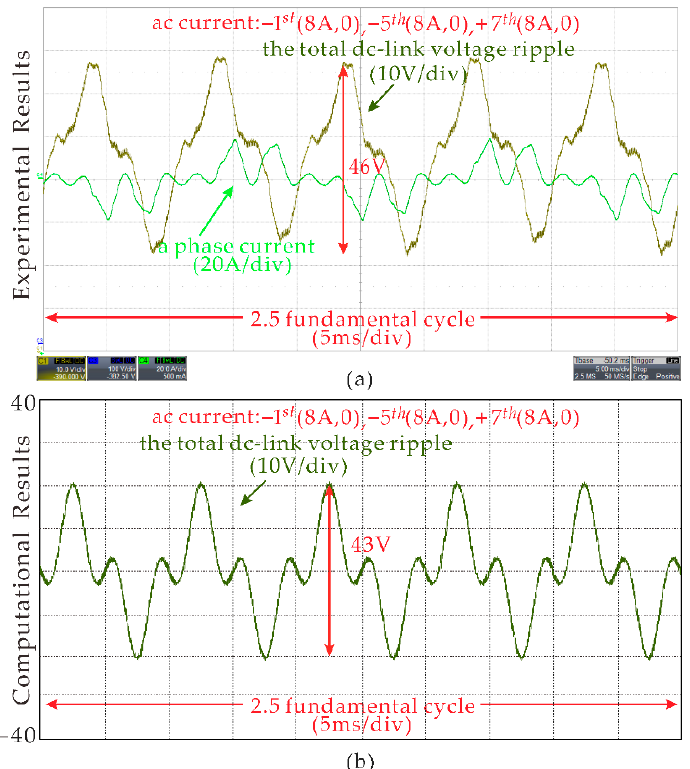
Figure 11. Experimental and computational results of the dc-link voltage ripple when the ac currents contain − 1st (8A, 0), − 5th (8A, π ), and +7th (8A,0): ( a ) experimental results; ( b ) computational results.